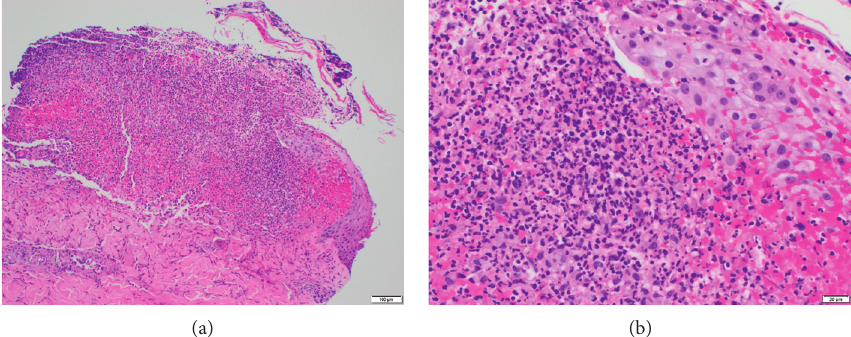
Figure 4: Skin biopsy showed dense dermal infiltrate of polymorphonuclear cells at both low (a) and high (b)